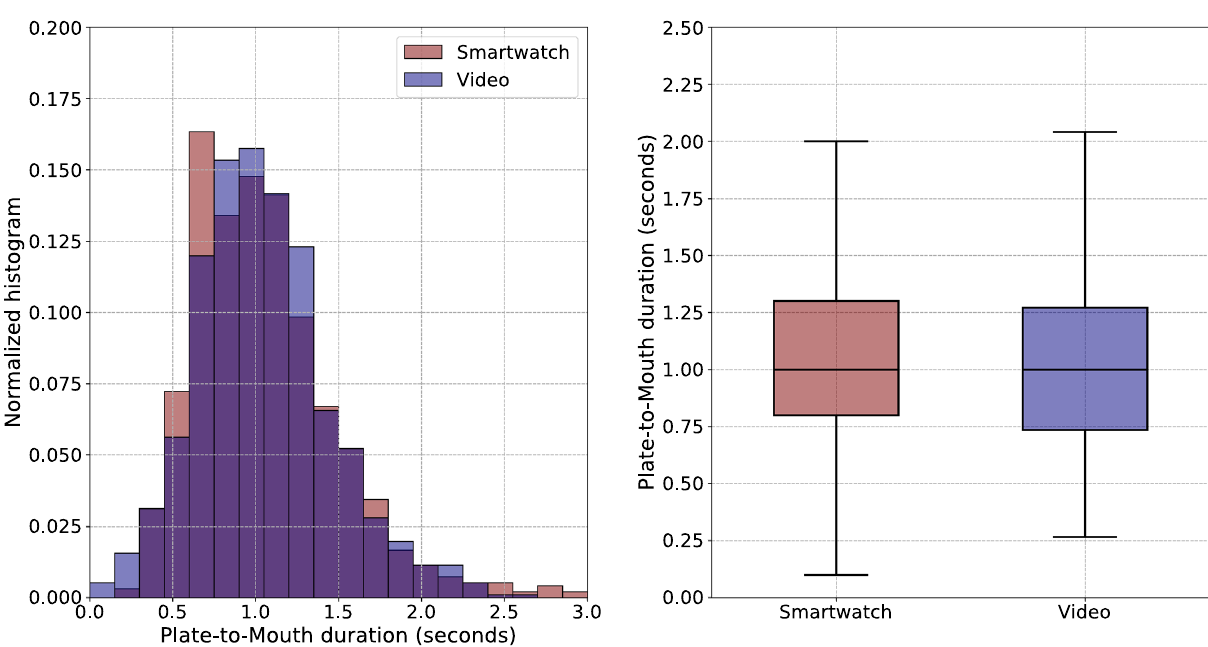
Figure 6. Comparison of the video and smartwatch-based extraction of Plate-to-Mouth durations ( n = 1036 ) in the context of EXII (EaC dataset). The normalized superimposed histograms (left) and box plots (right) showcase the large overlap between the two distributions. Regarding the left figure, the dark blue color represents the overlap between the two